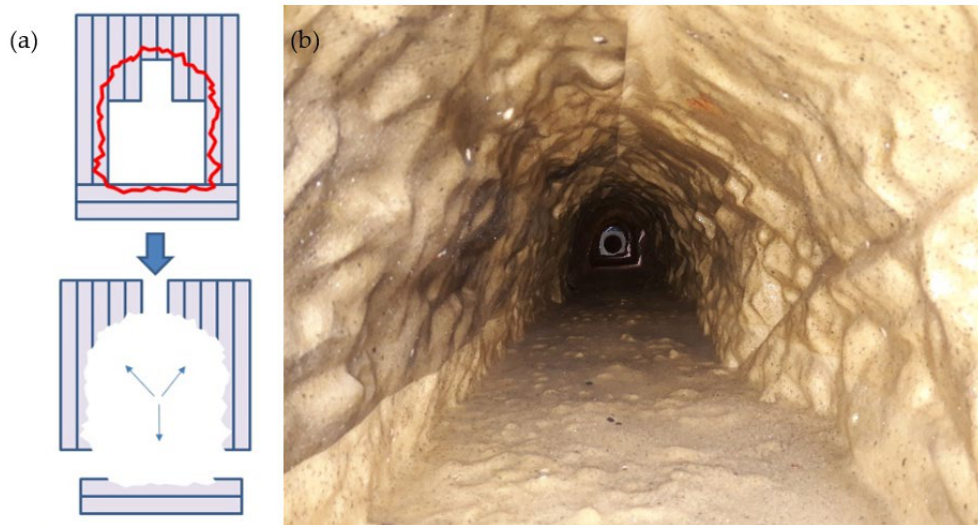
Figure 2. Blocks of glued plates (indicated by the blue lines) and planning of the milling for the three segments of a longitudinal tunnel section ( a ) and a photograph showing the view from the inlet into the tunnel ( b ).